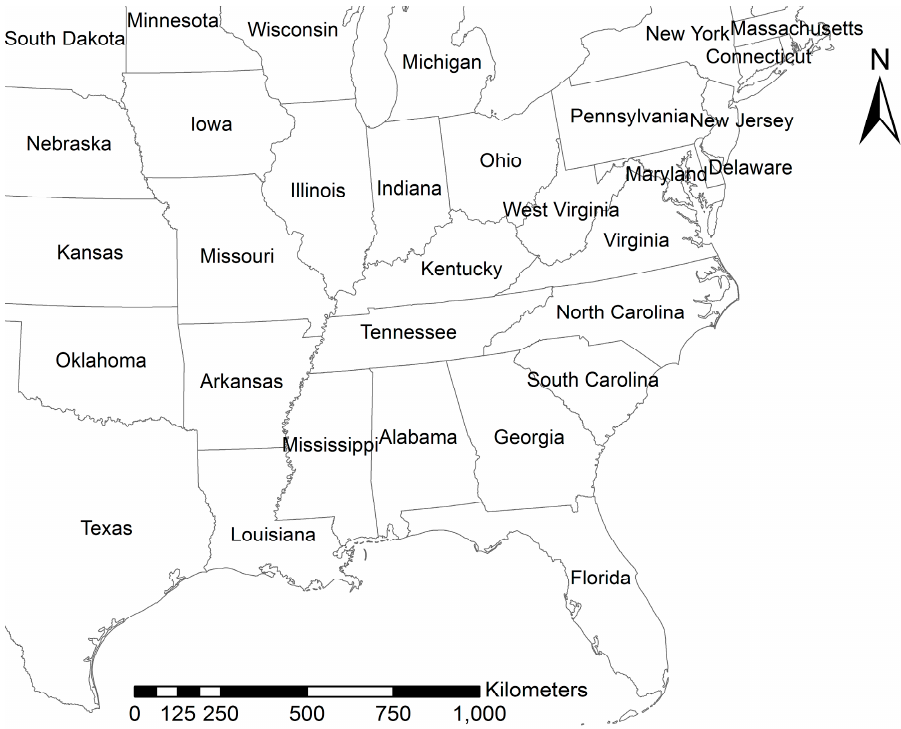
Figure A1. Names of states relevant to this study.